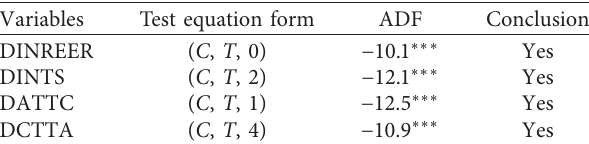
Table 1: Stationarity